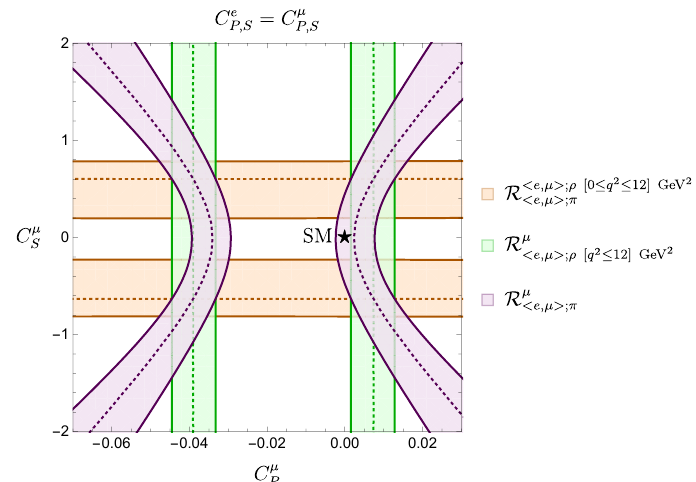
µ µ – C plane following from the observables P S